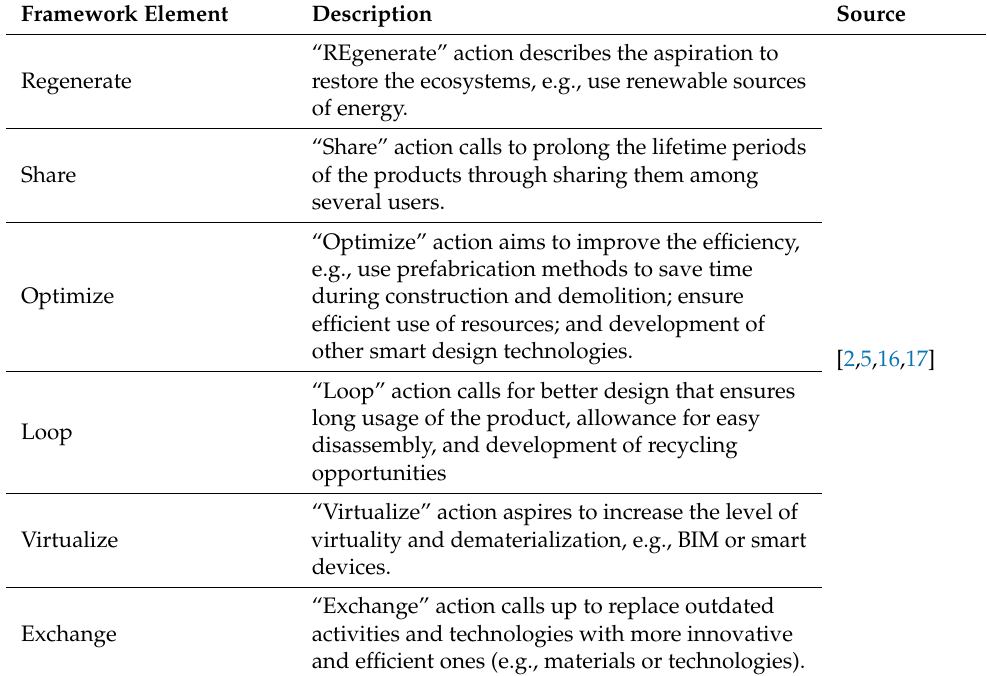
Table 1. ReSOLVE framework detailed